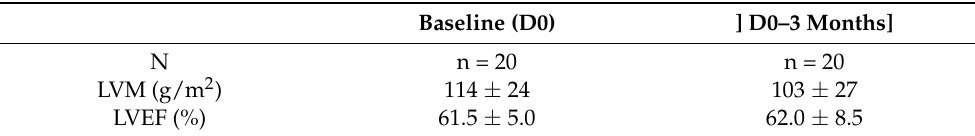
Table 5. Cardiological data—evolution of the LVM and LVEF during the first 3-month period of